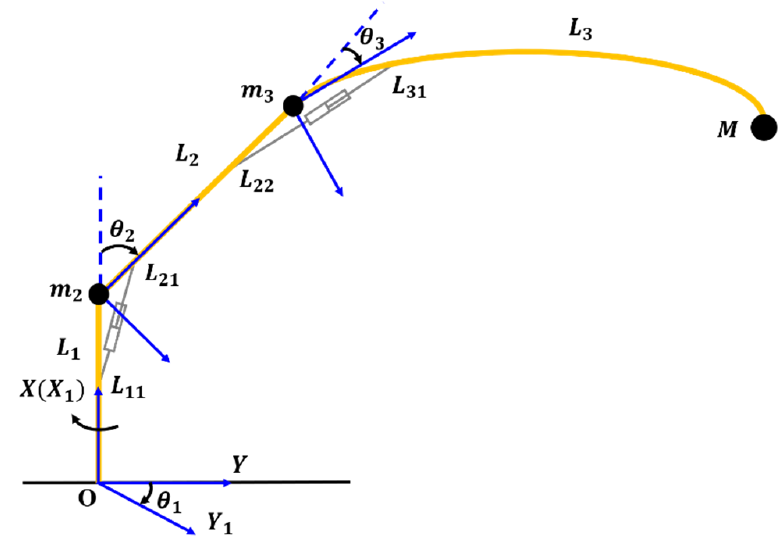
Figure 2. Schematic diagram of rigid–flexible manipulator.